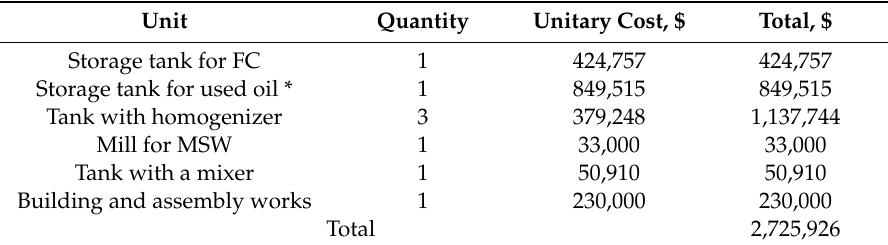
Table 10. Construction costs of central fuel preparation plant. Unit